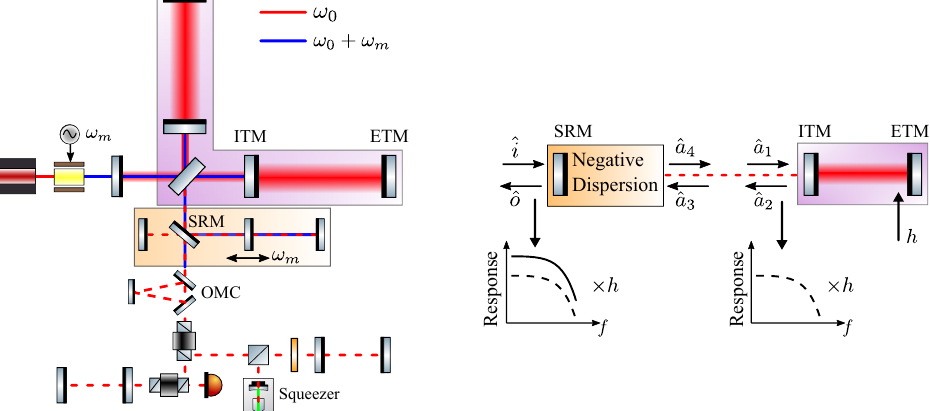
Figure 2. ( Left ): Gravitational-wave detector with the proposed BSR scheme and input/output filter cavities. The carrier laser is at ω 0 (red). The optomechanical filter cavity is pumped with a laser at ω 0 + ω m (blue), which comes from modulating the input carrier and transmits to the dark port under the Schnupp asymmetry. The resonant frequency of the mechanical oscillator is ω m . The blue beam is filtered with an output mode cleaner. The input and output filter cavities are used for frequency dependent squeezing and variational readout. ( Right ): Simplified schematic of the broadband signal recycling scheme. Inside the SRC, the phase of sideband upon reflection from the arm cavity is cancelled, therefor the SRC is on resonance in a broad frequency band. The SRC is converted to be an amplifier for the signal coming out from the arm cavity with a gain of 1/ √ T SRM